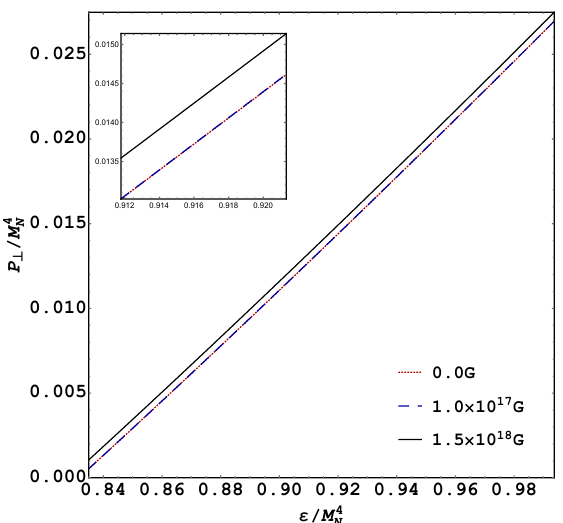
Figure 5. (Color online) Equations of state for the perpendicular pressure, for magnetic field strengths of 0.0 G (dotted), 1.0 × 10 17 G (dashed), and 1.5 × 10 18 G (solid). The curves for the two lower fields